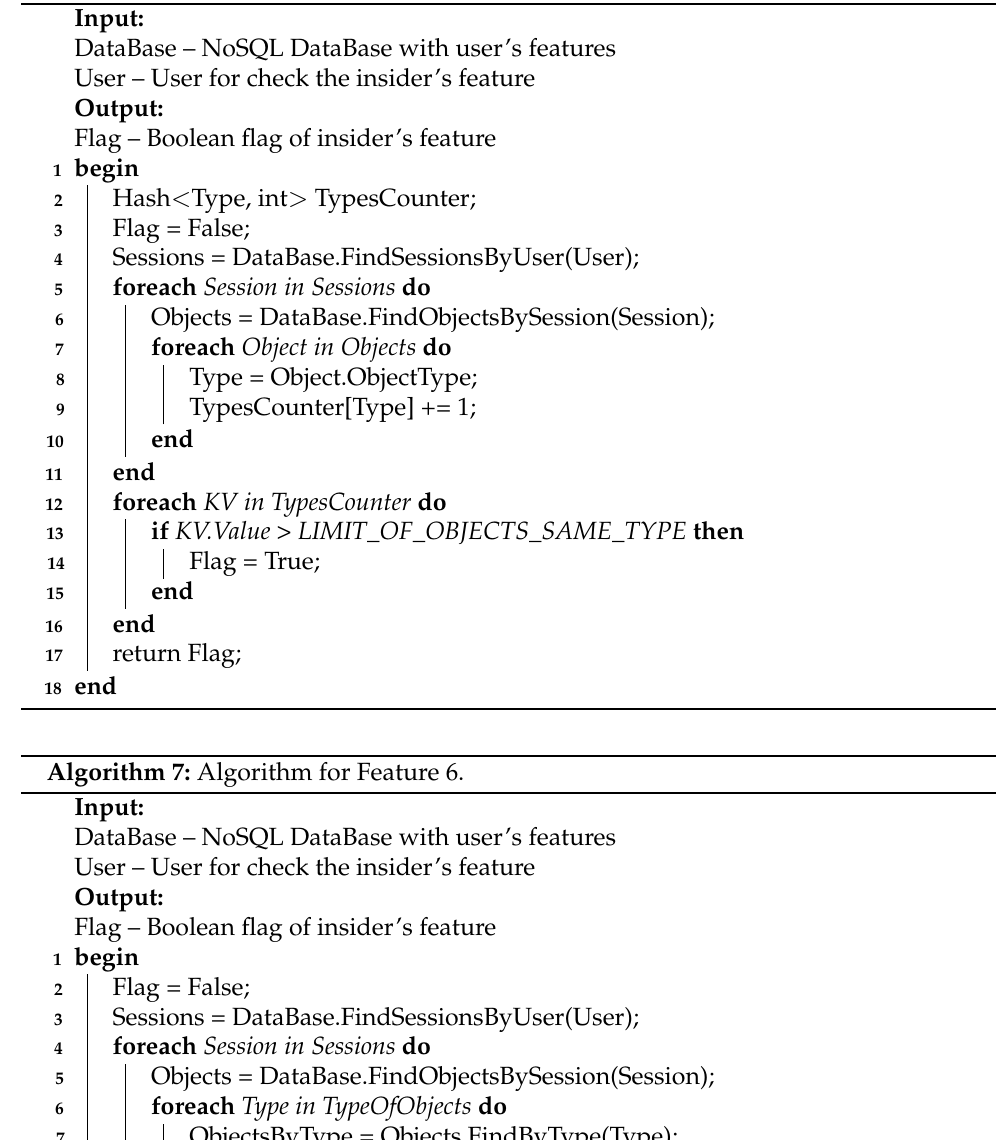
Algorithm 6: Algorithm for Feature 5.